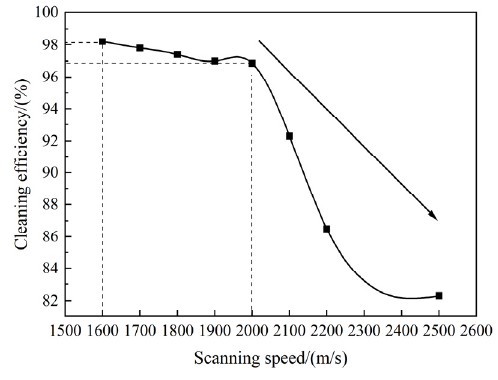
Figure 12. Relationship between the cleaning e ffi ciency and scanning speed.